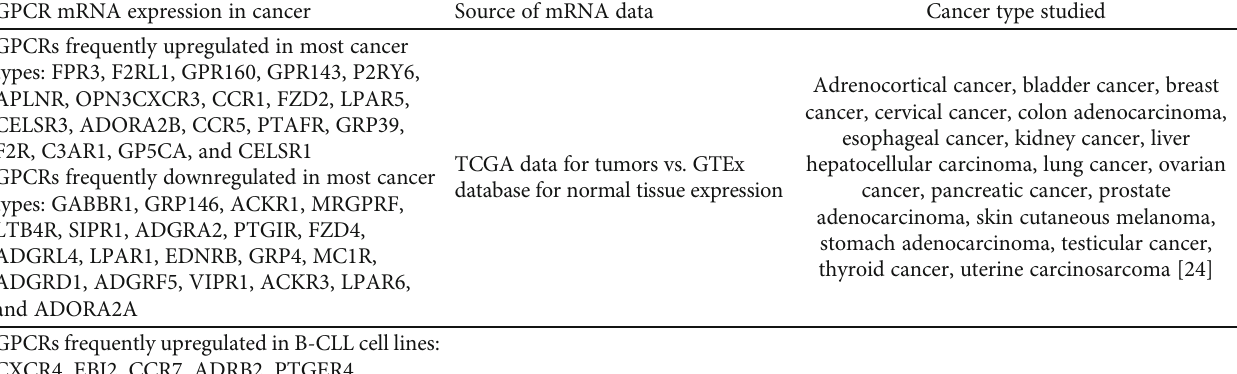
Table 1: Alteration of GPCR expression in